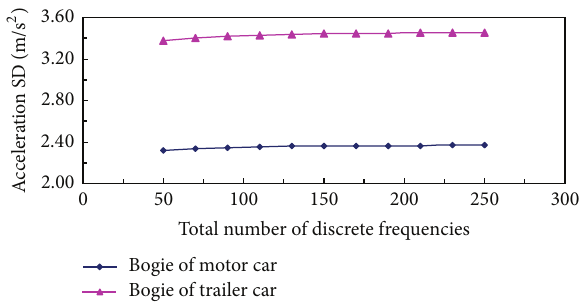
Figure 6: Maximum SD of vertical displacement of bridge mid-